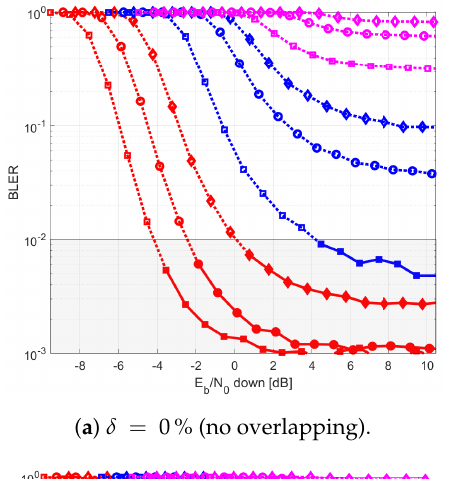
Figure 16. End-to-end throughput envelope for all cases under study versus E b / N 0 in the access link. Case 1 (continuous red line), Case 2 (dotted blue line), and Case 3 (dashed magenta line) (left side). On the right, gain in the end-to-end throughput of Cases 2 (continuous red line) and 3 (dashed blue line) with respect to Case 1. Wind speed: v = 21m/s. Diameter of telescope aperture: W 0 = 10cm.